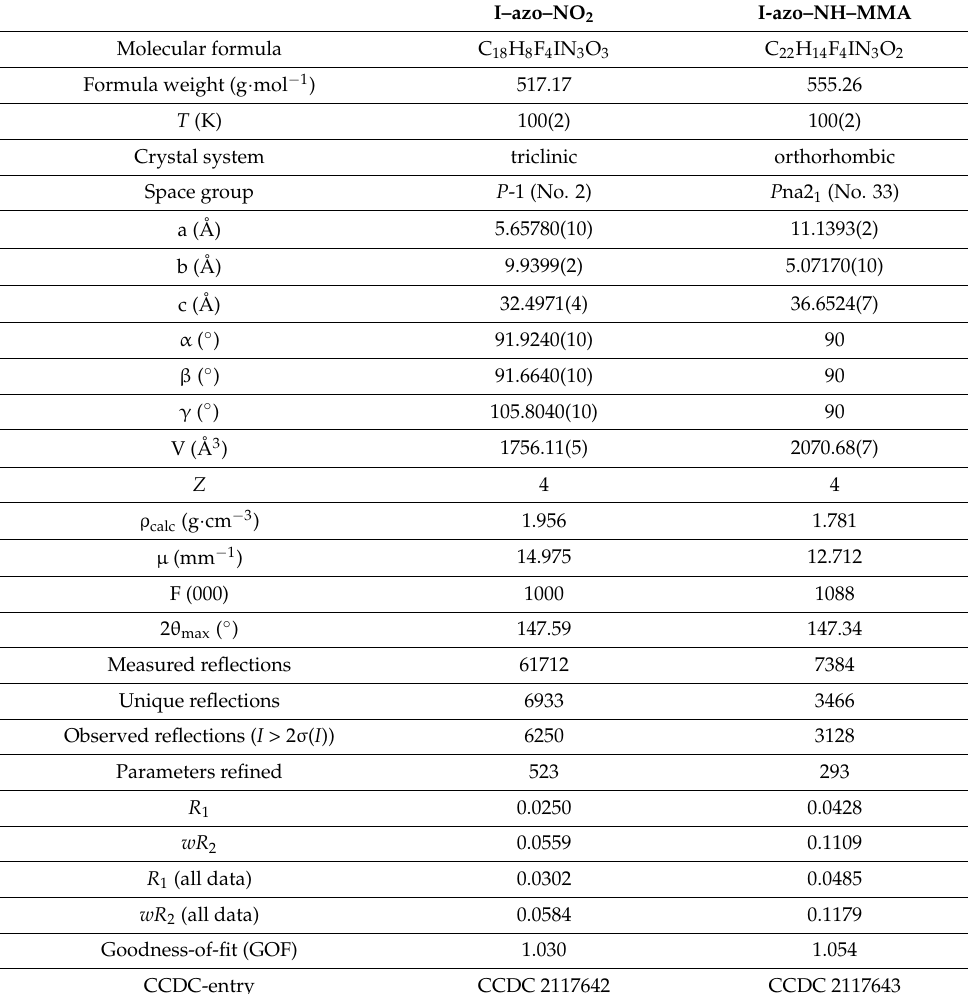
Table 1. X-ray crystal data and refinement parameters for structures I–azo–NO 2 and